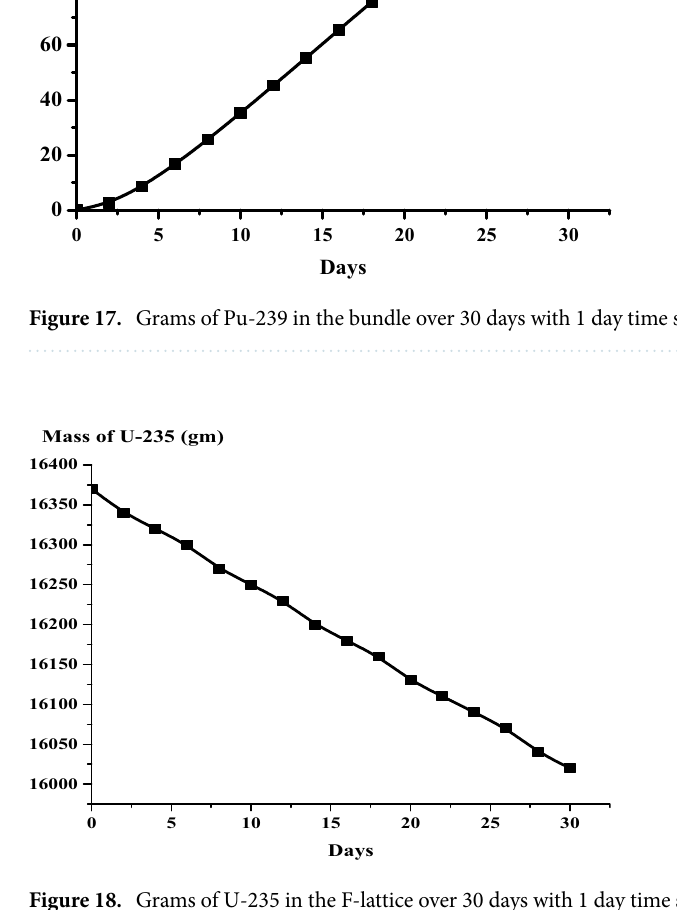
Figure 18. Grams of U-235 in the F-lattice over 30 days with 1 day time